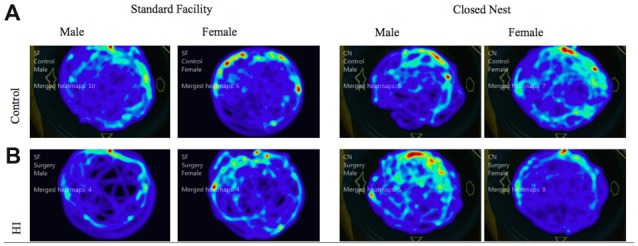
(A,B) Probe trial: average swim path by surgery condition and housing for males and females. The following heat maps mark the average swim path during the probe trial. The markings represent aggregate data from CN and SF housing conditions for each sex according to surgical condition: (A) Control, (B) HI Injury. The maps illustrate that HI SF animals had significantly longer swim paths than either HI CN, Control SF, or Control CN animals (F(1) = 7.115, p < 0.01). For swim speed velocity, there was no difference between surgical conditions, but there was a significant effect of housing condition, with SF females demonstrating a faster swim speed than CN females (F(1) = 7.05, p < 0.01).